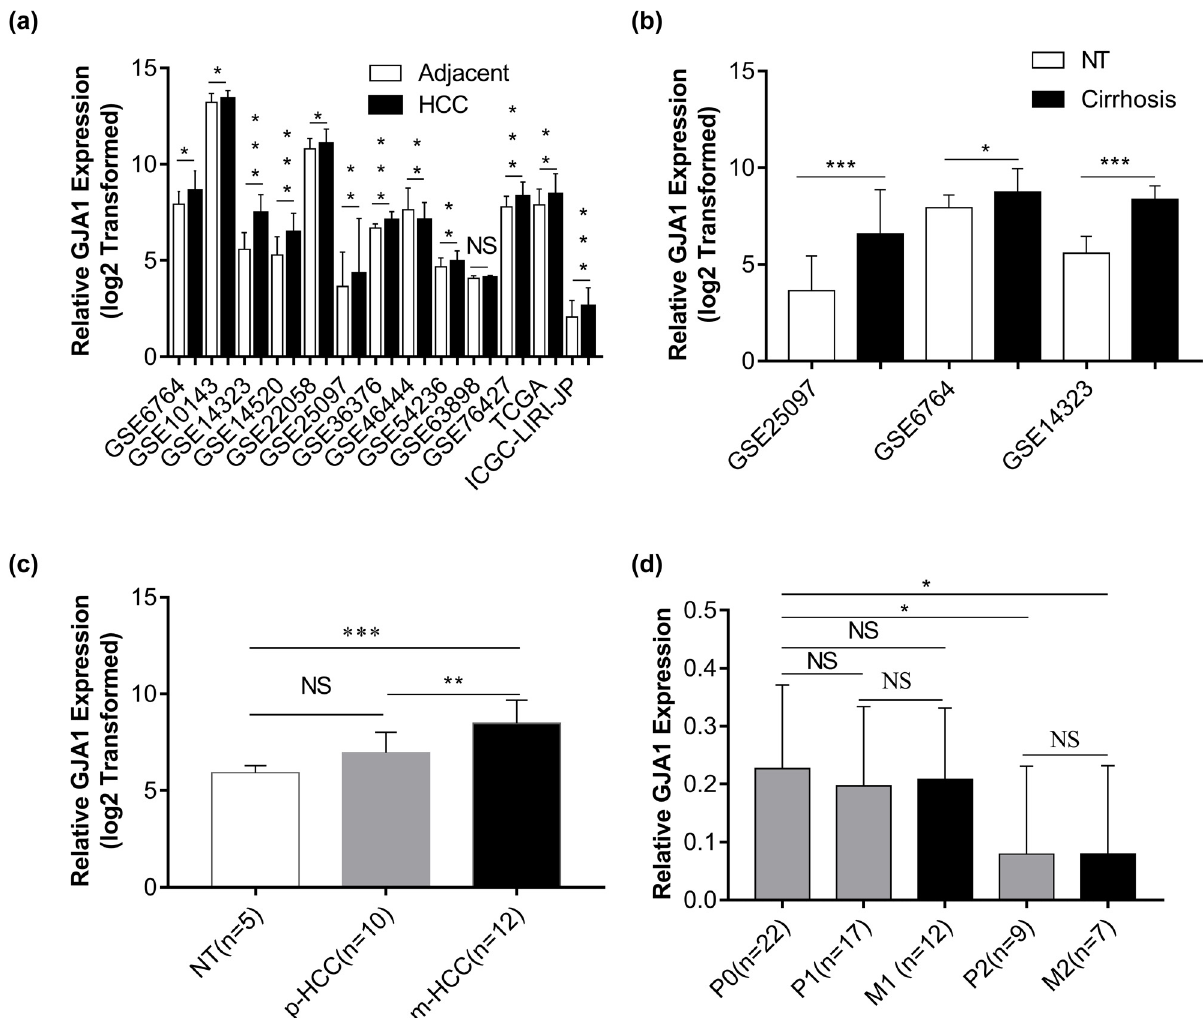
Figure 1: GJA1 is upregulated in HCCs and hepatic cirrhosis. The expression of GJA1 was compared between HCCs and adjacent NTs ( a ) , between hepatic cirrhosis and NTs ( b ) , between pulmonary metastases from HCCs ( m - HCC ) and primary HCCs without metastasis ( p - HCC ) ( c ) , and between HCCs with intrahepatic metastasis ( M1 ) or with portal vein tumor thrombus metastases ( M2 ) and their corresponding primary HCCs ( P1 or P2 ) or primary HCCs without metastasis ( P0 ) ( d ) . GJA1, gap junction protein, alpha 1; HCC, hepatocellular carcinoma; NS, not signi fi cant; NT, nontumor tissue; * p < 0.05; ** p < 0.01; *** p < 0.001 vs the control